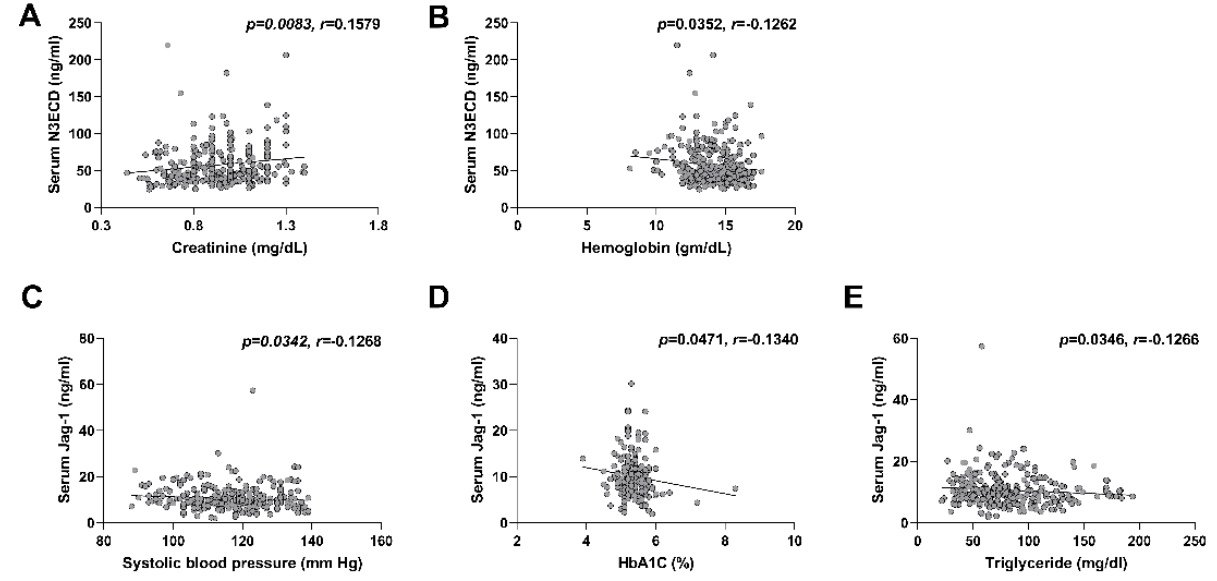
Figure 3. Comparison of mean N3ECD and Jagged-1 levels by gender and age. Serum and plasma N3ECD levels between male and female ( A ) and correlations between N3ECD levels and age ( B ). Jagged-1 serum and plasma levels in male and female ( C) and correlations with age ( D ). Each sym- bol represents values from a single subject; midline represents the mean; and error bars represent the standard error. The resulting Spearman’s correlation coefficient ( r ) and corresponding p -value are reported. ns—not significant.